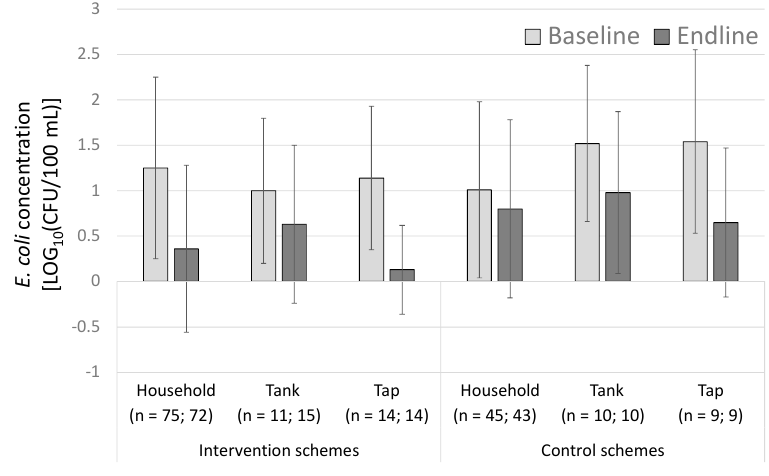
Figure 6. Mean E. coli contamination at each sampling point at the baseline and endline measurements for the intervention and control schemes. The standard deviation bars are shown.